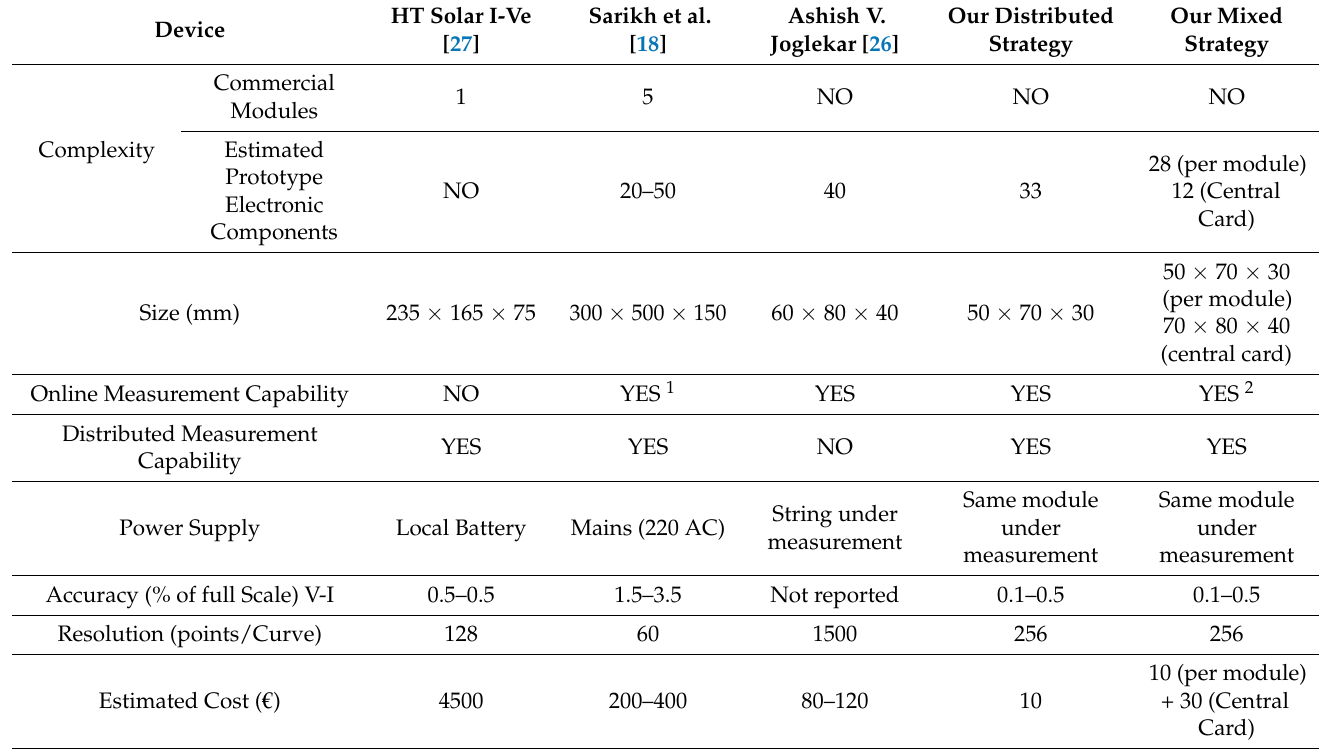
Table 4. Comparison of I-V tracer devices regarding complexity, size, online or distributed measurement capability, power supply requirements, accuracy, resolution, and